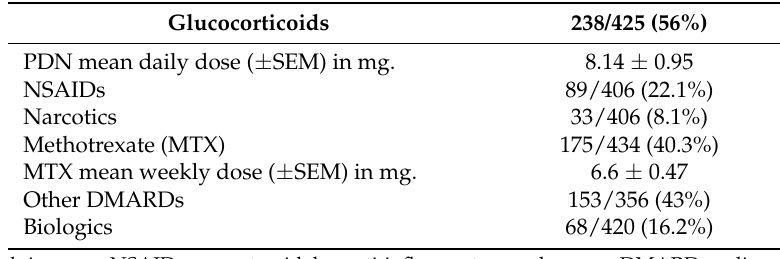
Table 4. Therapeutic Management.